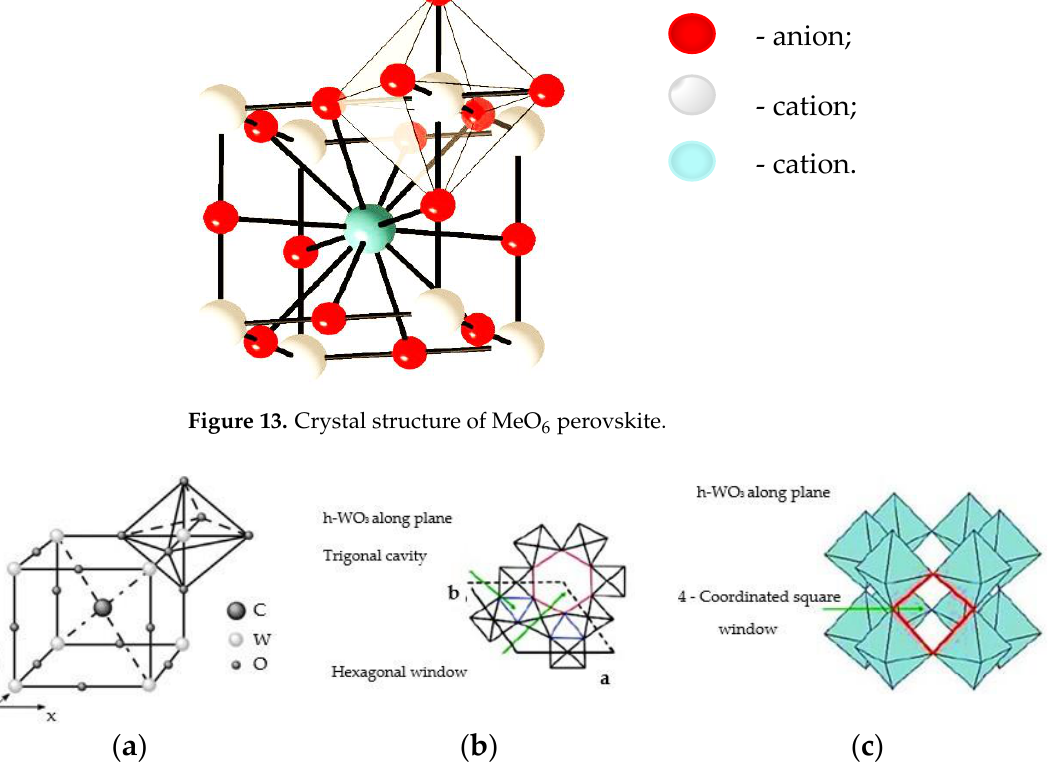
Figure 14. Crystal structure of СWO 3 perovskite: ( а ) general view; ( b ) h-WO 3 along plane; ( c ) h-WO 3 along plane.